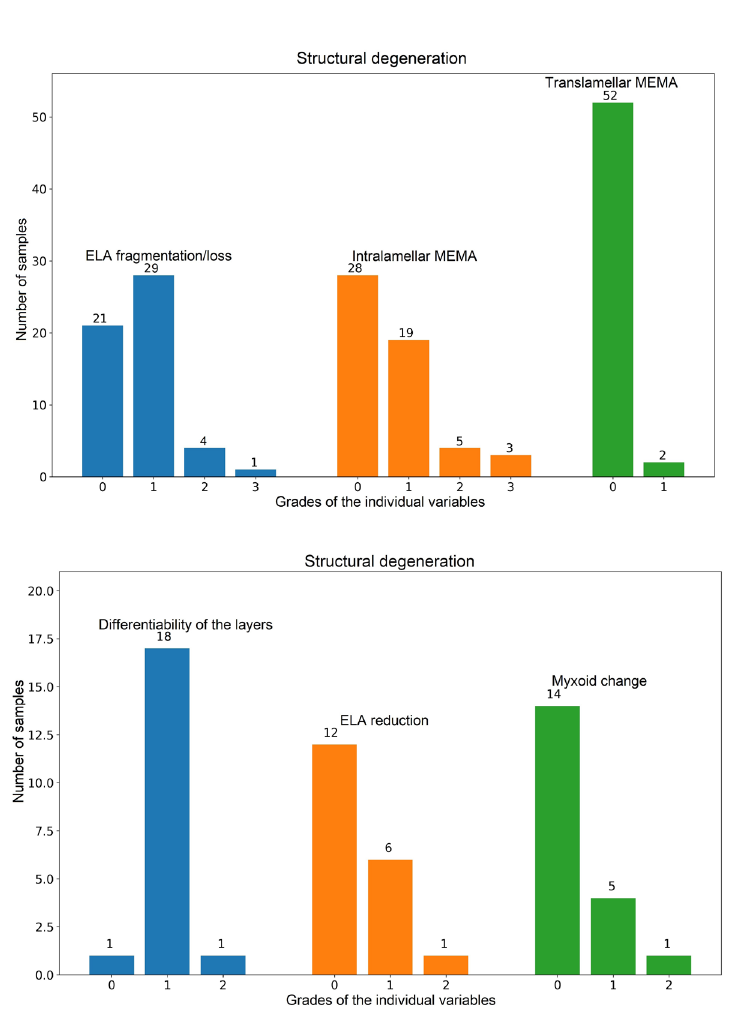
Fig. 1 - Bar plots showing individual components of structural degeneration in arterial (A) and valvar (B) samples (only the non-zero variables are shown). X-axis shows grades of severity for each individual variable, y-axis provides number of samples in each category (different colors of the bars were used only for a better understandability of the picture). ELA=elastic fiber; MEMA=mucoid extracellular matrix